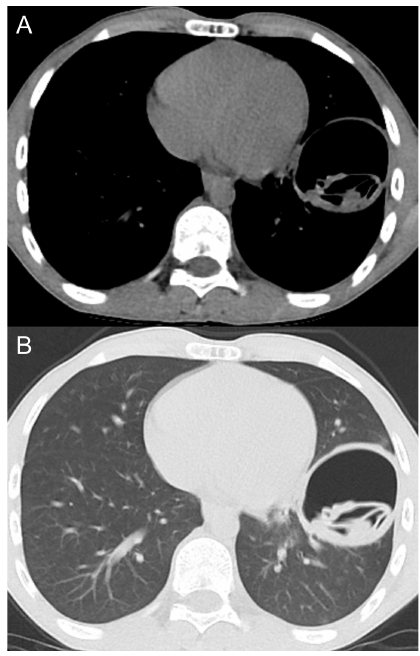
Figure 4. a,b. In a 14-year-old male, images of the air and laminar membrane in the cavity of the ruptured cyst in the left lower lobe are seen on the thorax computed tomography mediastinum (a) and parenchyma sections